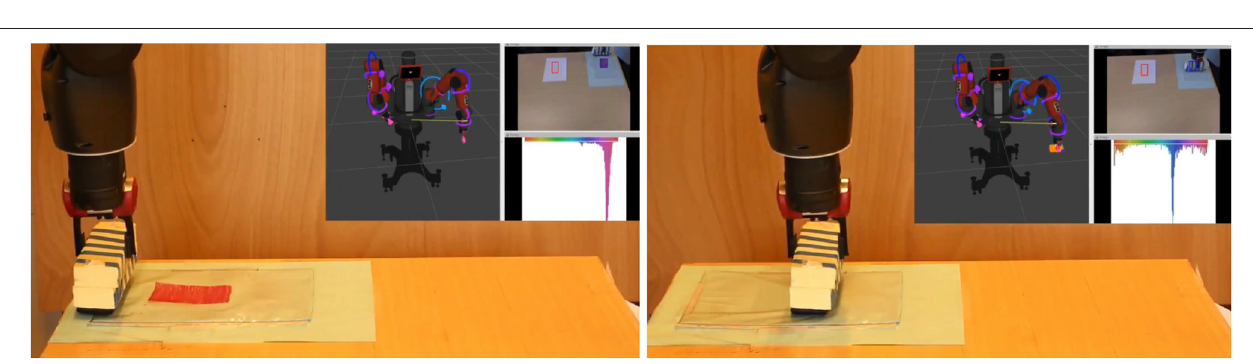
FIGURE 6 | Example of captured effects when performing the action wipe on the object duster . Left figure shows the spatial (pose) and perceptual (color) state of the duster , and the surface . After wipe action is performed, the effects on position and in hue are detected: duster has changed position but not color, surface has changed color but not position. Although for this experiment we do not use the force in the joints, we are also capturing these